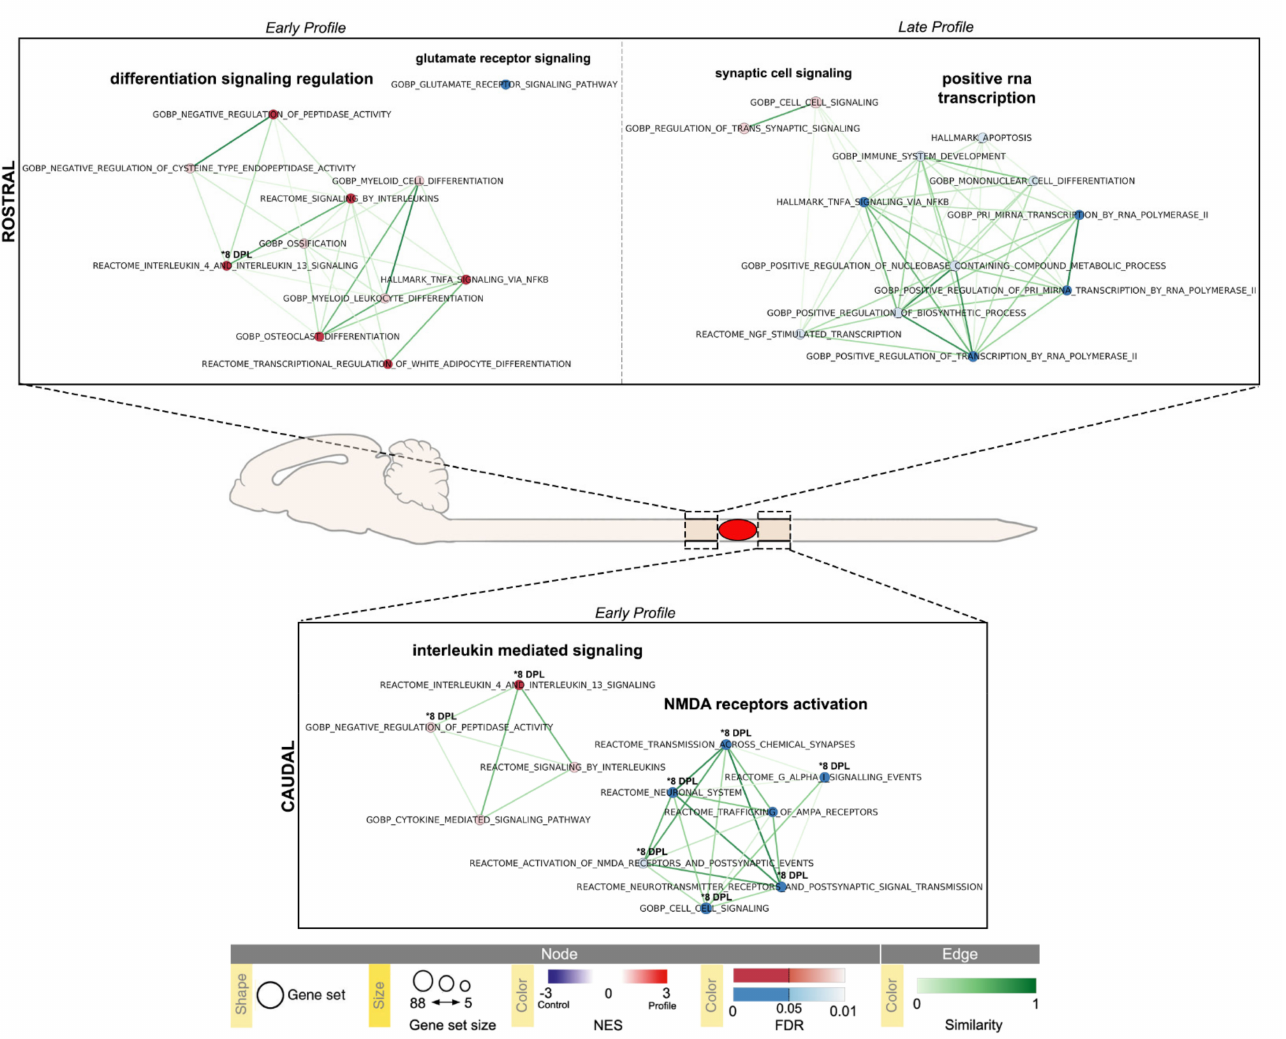
Figure 6. Time-series Gene Set Enrichment Analysis (GSEA) of Spinal Cord (SC) rostral and caudal segments visualized using Enrichment Map Cytoscape App. Results with absolute Normalized Enrichment Score (NES) ≥ 1.5 and False Discovery Rate (FDR) ≤ 0.1 are reported (SC rostral early 1–8 DPL and late 45 DPL profiles, Table 1; SC caudal early 1–8 DPL profiles, Table 2); pathways with FDR ≤ 0.05 are highlighted. Temporal profiles are labeled as Early Profile (peak at 1 DPL) and Late Profile (peak at 45 DPL); 8 DPL pathway enrichments (FDR ≤ 0.05) are individually marked (* 8 DPL). Pathways (circles) are connected by edges (lines) based on their similarity score and grouped into labeled clusters using AutoAnnotate application v.1.3.4. Red dots denote positively associated pathways (enriched respect to control, NES ≥ 1.5) and blue dots denote negatively associated pathways (decreased respect to control, NES ≤ − 1.5). Edge width denotes overlap between